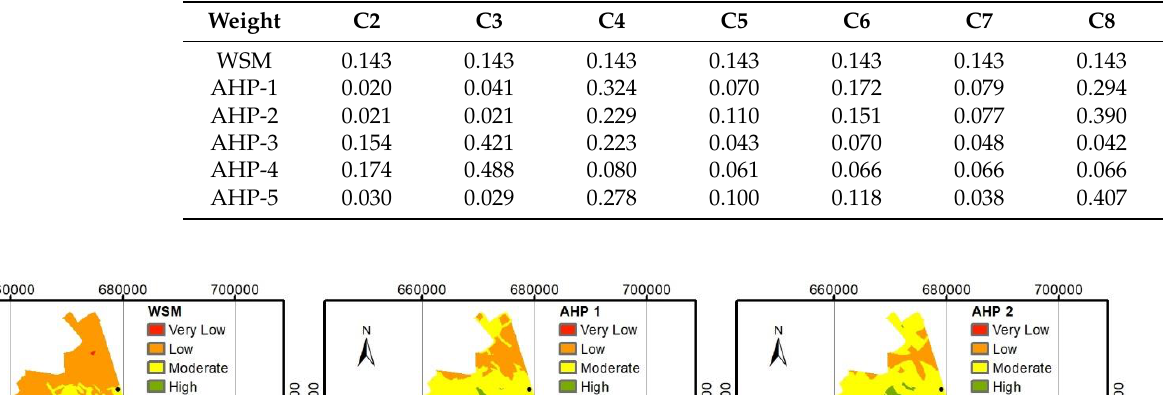
Table 5. The weight of the predictive factors suggested for the six models (WSM and five AHP).